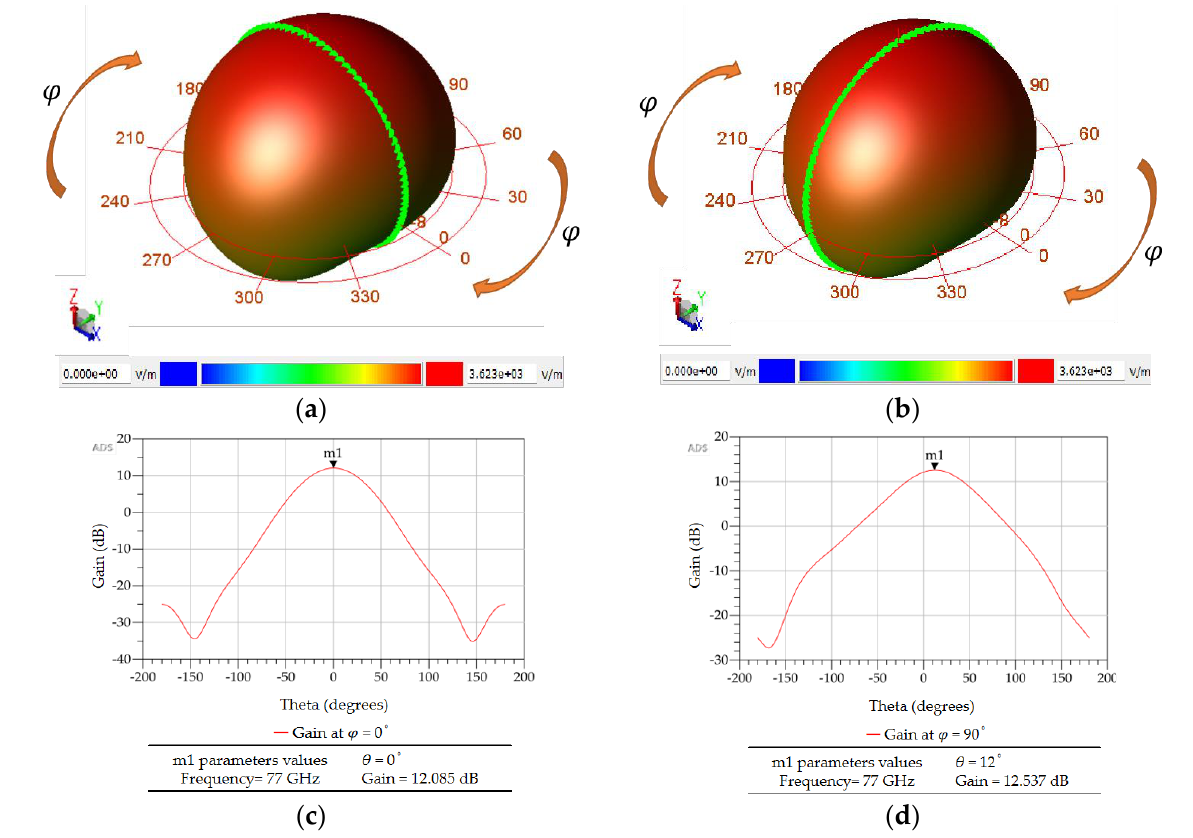
Figure 19. ( a ) 3D radiation pattern of a single inset – fed microstrip patch antenna at 𝜑 = 0°. ( b ) 3D